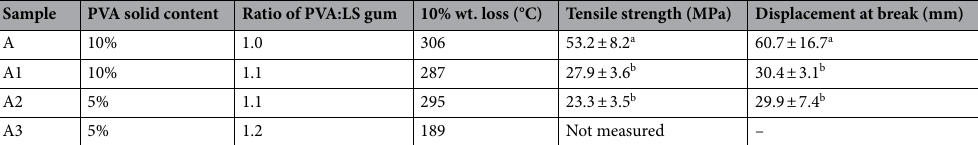
Table 2. Composition, thermal and mechanical characteristics of prepared films. Results represent the means of 3 replicates ± sd. Different superscript letters indicate significant differences (p < 0.05).